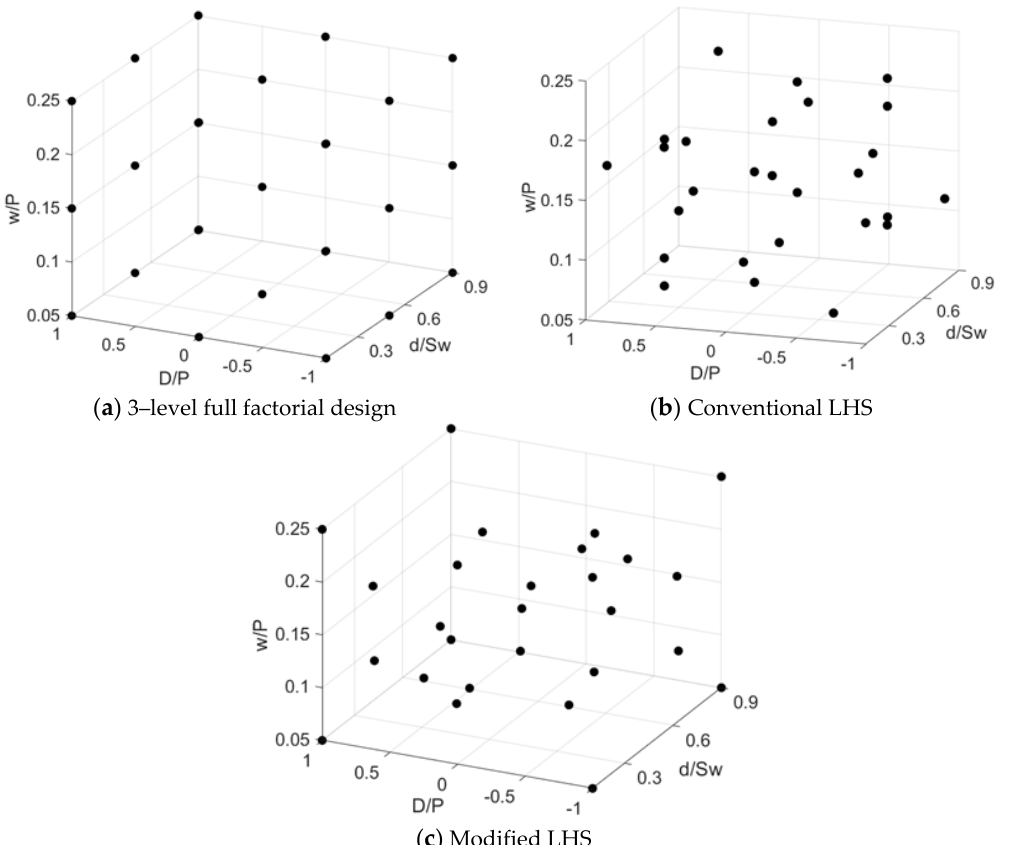
Figure 14. Distributions of sample points for three different DOEs.